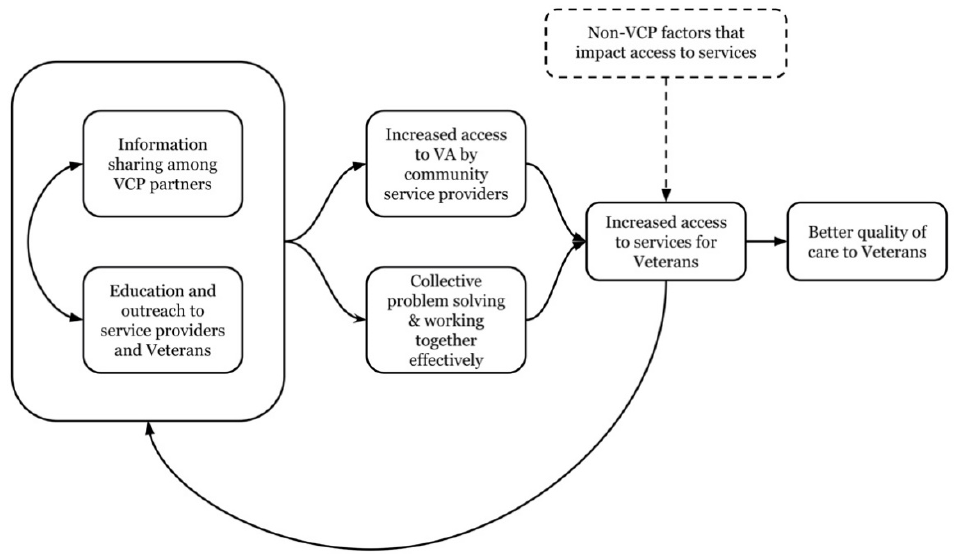
Figure 1. Relationships among VCP goals identified by focus groups.